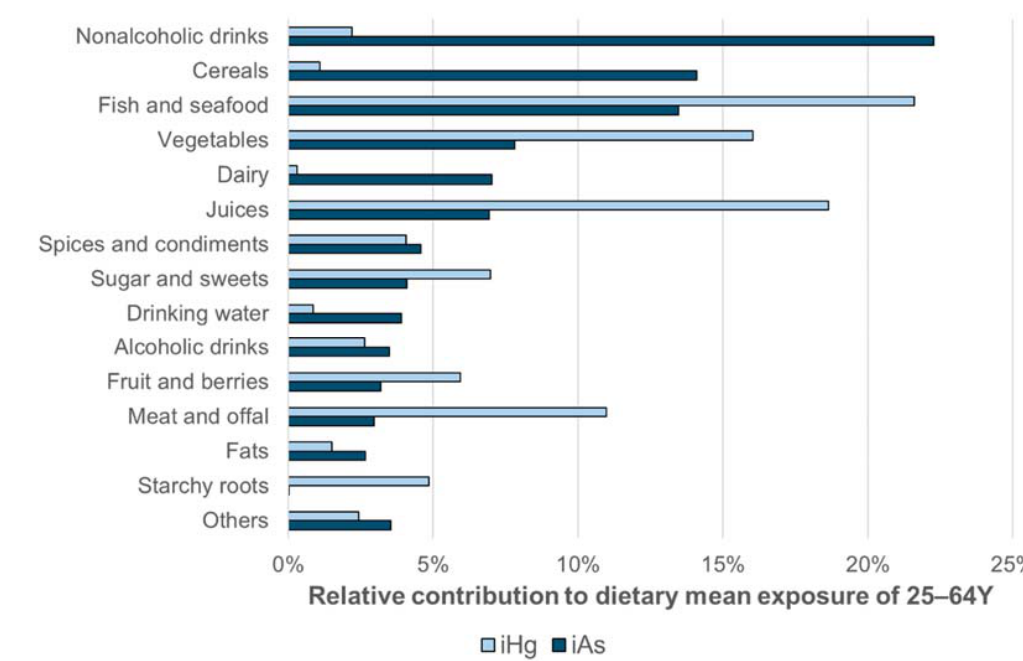
Figure 2. Relative contributions of different food groups to inorganic arsenic and inorganic mercury exposure of the average consumer of 25 to 64 years, according to FinDiet 2012 consumption data. Food groups are shown in order of importance for iAs. The group “Others” in this figure includes legumes, nuts and oilseeds, eggs, weight loss products, supplements and combination foods. The assumptions for the portion of inorganic compounds out of the measured total arsenic or total mercury are detailed under Materials and Methods.